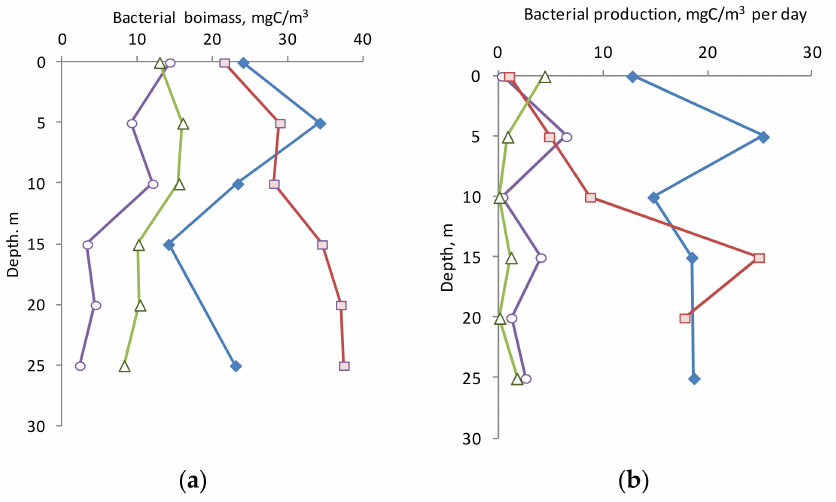
Figure 5. Vertical distribution of bacterial biomass ( a ) and bacterial production ( b ) for April (circles), June (rhombus), October (squares), and November